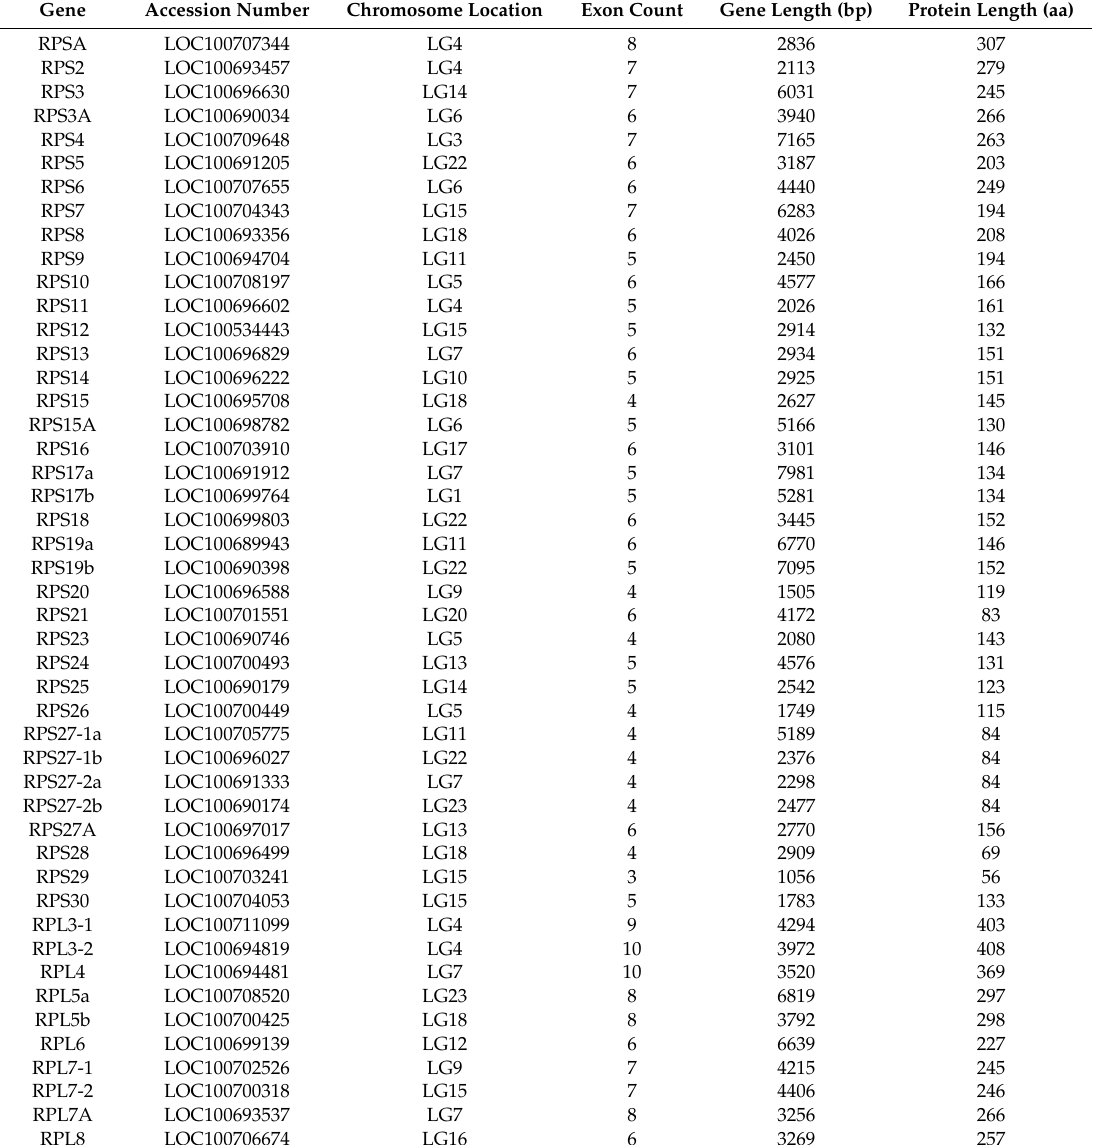
Table 1. Ribosomal protein (RP) genes identified in Nile tilapia